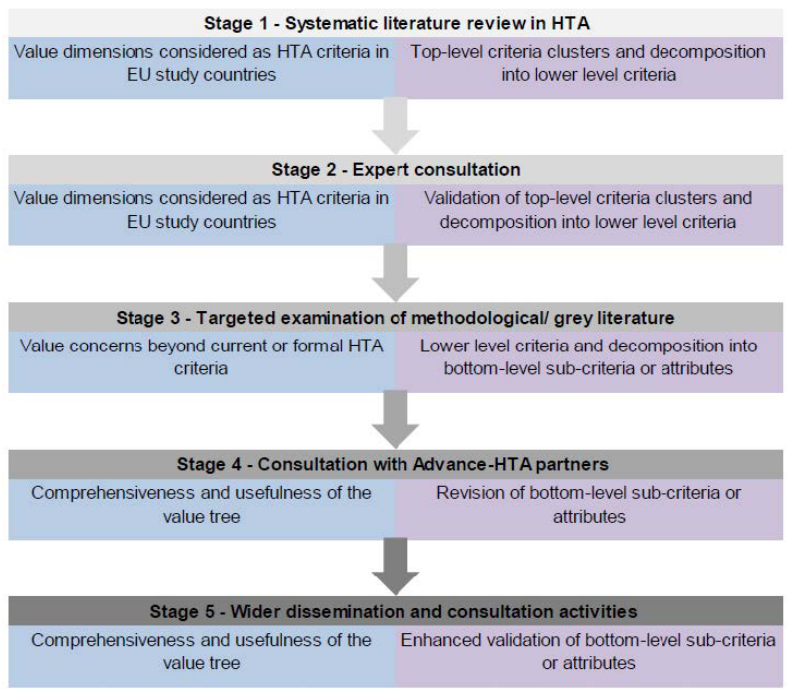
Fig. 1 The economic evaluation process of multi-attribute